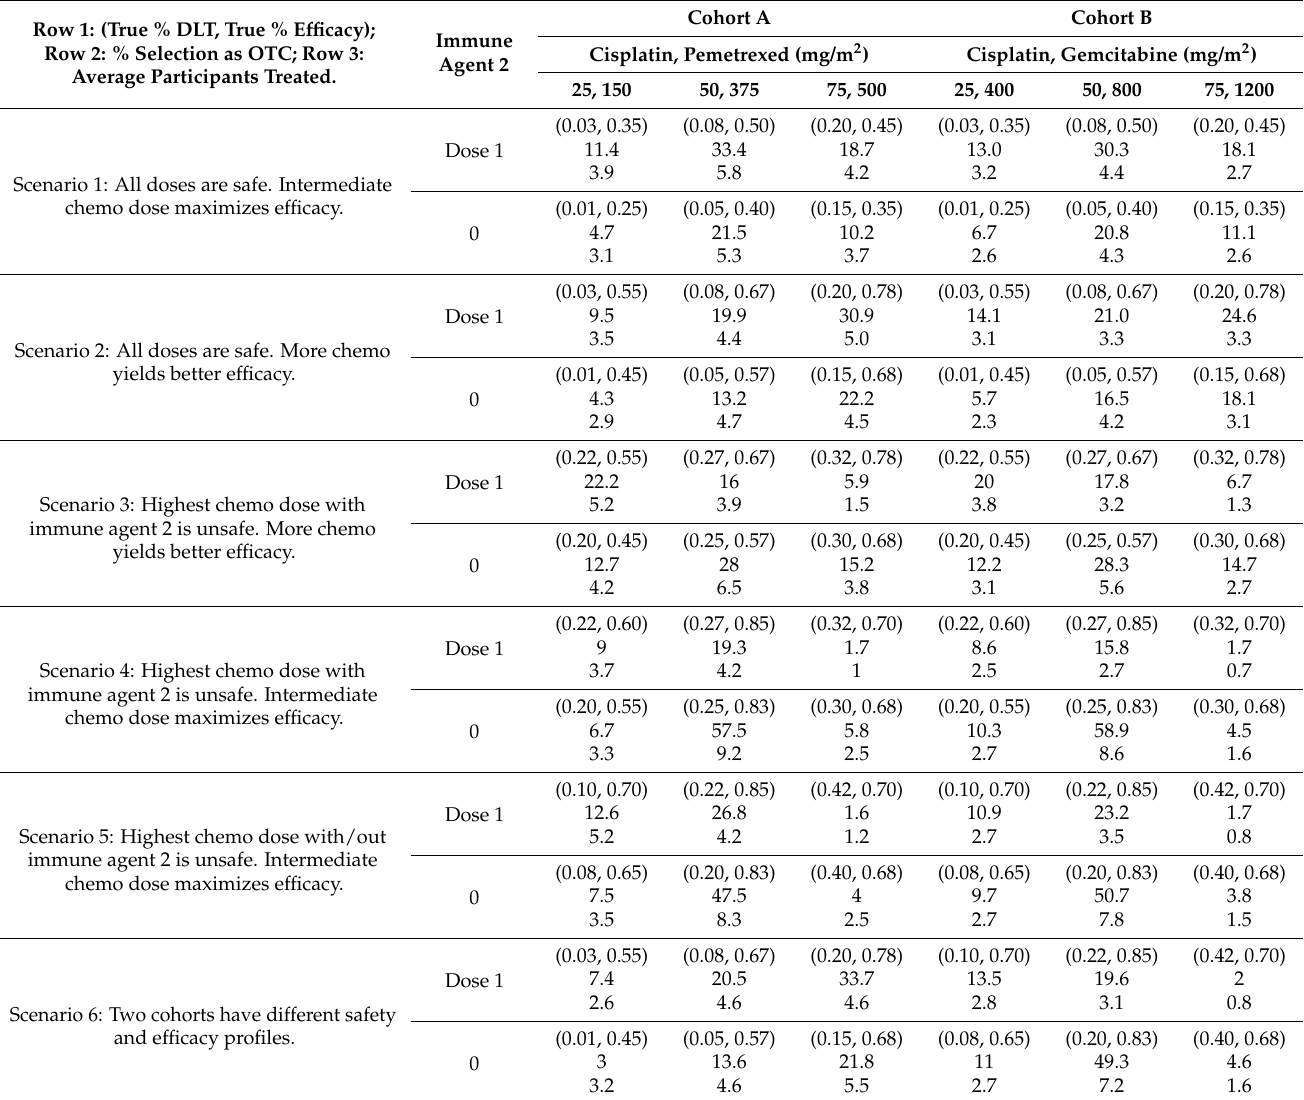
Table 4. Operating characteristics for Cohorts A and B.